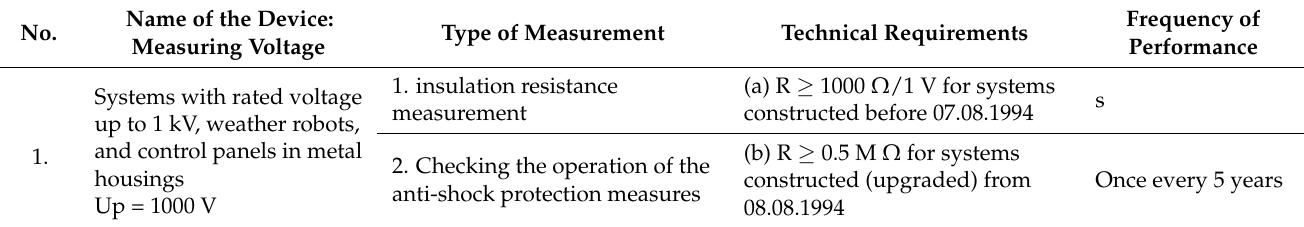
Table 3. Operational measurements for EOR devices—periodic inspections, thermovision inspection (own study based on [29]. Name of the Device: No. Measuring